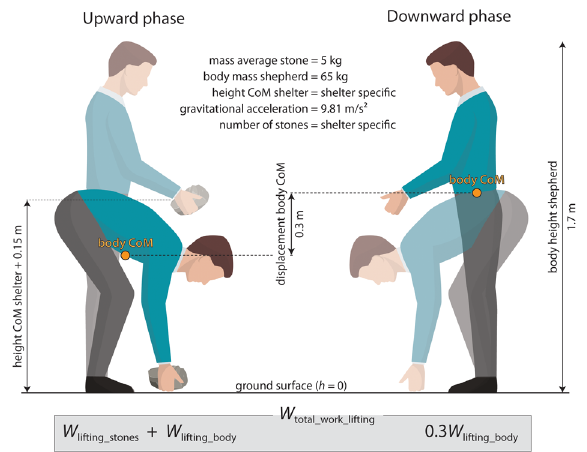
Figure 5. All the variables that are used in the biomechanical approach to estimate the builder’s total lifting